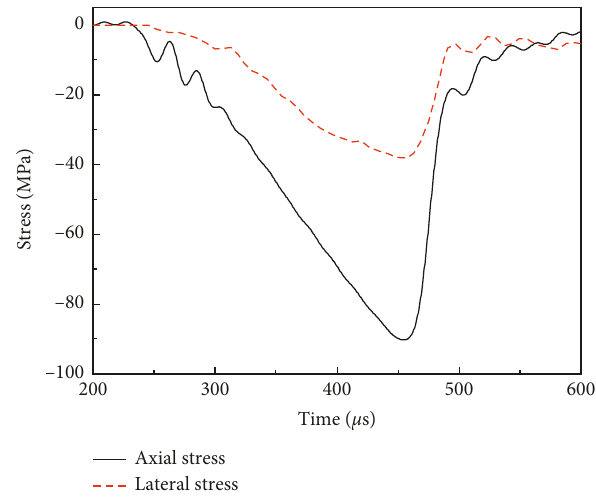
Figure 9: Typical axial stress and lateral stress histories of cal- careous sand (test group number: Figure 10. The results show that the lateral stress coefficient increases as the axial stress increases.